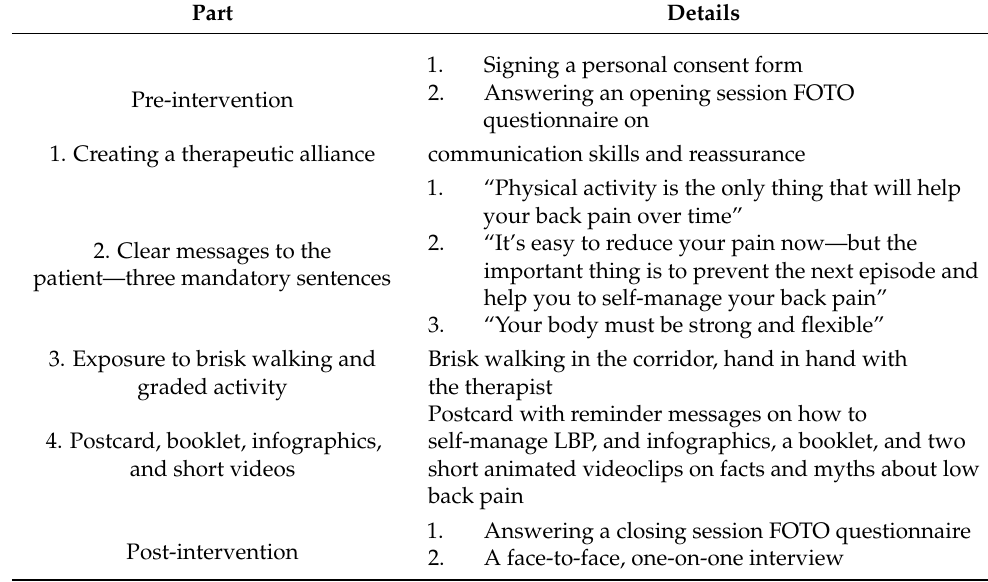
Table 2. Study procedure based on the four parts of the ETMI